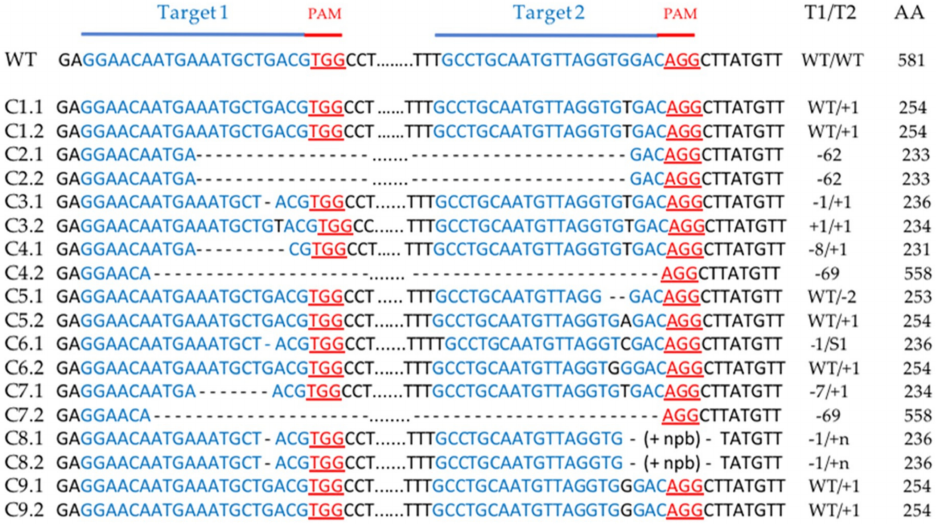
Figure 5. Sequence analysis of the two alleles of 9 albino calli obtained after protoplast transformation. The target sequences are depicted in blue and the PAM sequences in red. The change in the number of nucleotides is shown on the right of each allele sequence. A + or a – indicate an insertion or a deletion, respectively. A S means that there is a substitution. WT indicates that there is no mutation. Example: -5/WT = deletion of 5 nucleotides on the first target site, no mutation on the second target site. The length of the amino acid chain in the truncated protein is shown on the right. Cx.x: Callus x allele x; AA: Amino Acid chain length; T1: Target1; T2: Target2. (+ npb) = n base pairs resulting from insertion of plasmid